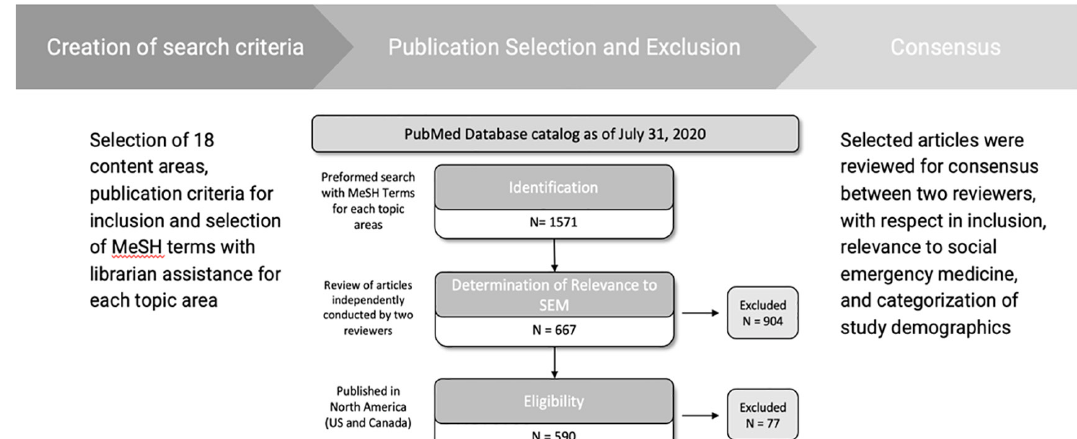
Figure 1. Publication selection and exclusion for all topic areas.